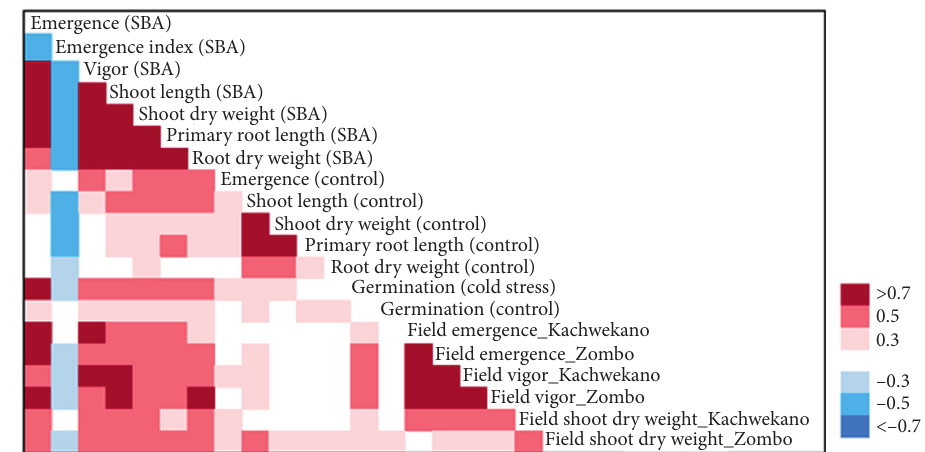
Figure 1: Heat map showing Pearson’s correlation (r) between cold tolerance traits evaluated under soil-based conditions and field trials at both locations. SBA, soil-based assay. Table 7: Relative ranking of sorghum lines based on rank summation index values from soil-based assay and field trial. Soil-based assay Field trials Entry